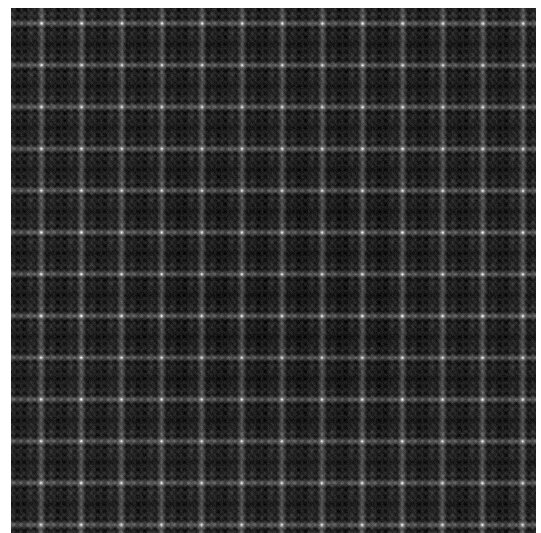
Figure 4. Correlation map from the patches in Figures 2b and 3.